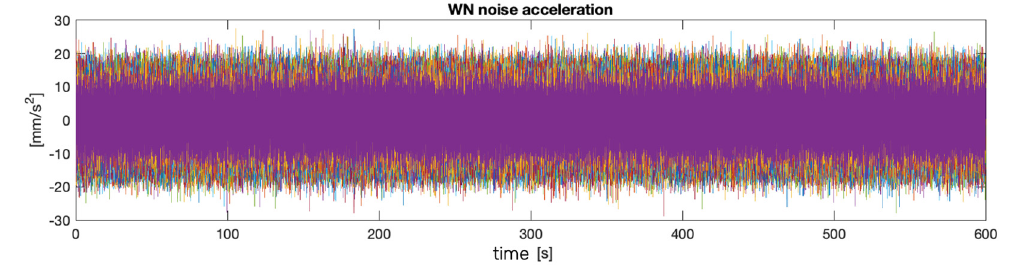
Figure 4. Gaussian stochastic processes.